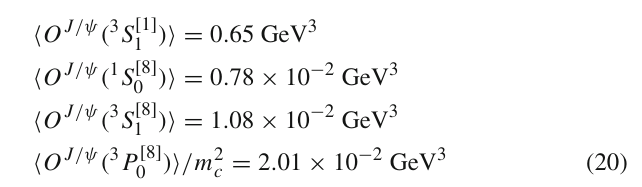
the exclusive double J /ψ production cross sections at B- factories given in Ref. [30]. Adopting different values of m c and μ r , the QCD NLO results range from − 3 . 350 to 2 . 312 fb, comparing with which, our results on the dou- ble J /ψ production in association with light hadrons are even smaller. The constraint on the double J /ψ produc- tion cross section given in Ref. [24] is σ( J /ψ + res ) × < 9 . 1 fb, where B > B > 2 2 denotes the branching fraction for final states with more than two charged tracks.